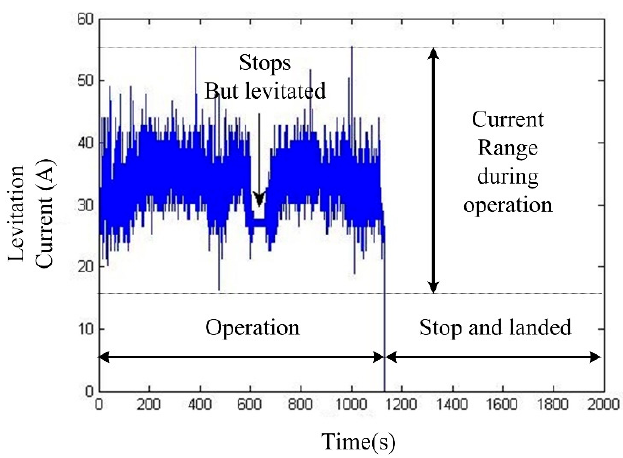
Figure 3. Levitation current of single one-way trip in mission